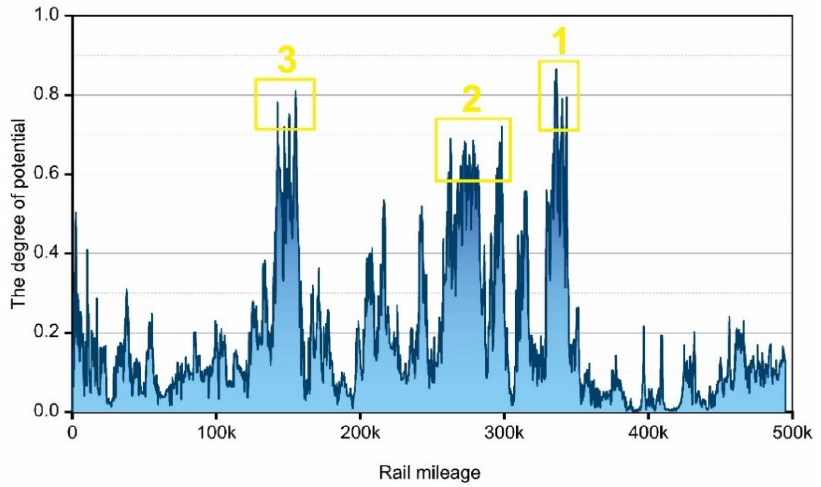
Figure 9. Superposition analysis of the Yunnan–Tibet railway and the MaxEnt model prediction results (the numbers 1/2/3 used in the figure are three key geothermal disaster